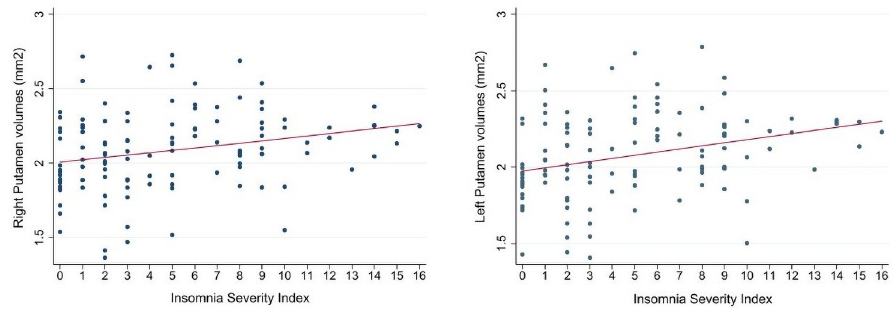
Fig 4. Correlation between Putamen volumes and Insomnia Severity Index. Scatter plot showing the correlation of the normalized volumes of right and left putamen with ISI scores (n = 120).